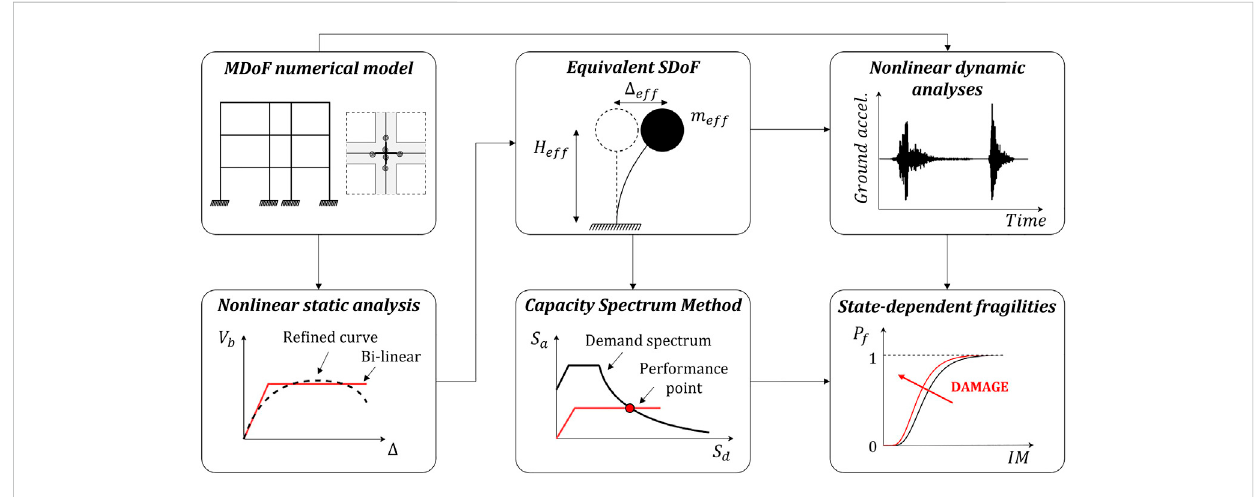
FIGURE 4 Different seismic response analysis methods for state-dependent fragility